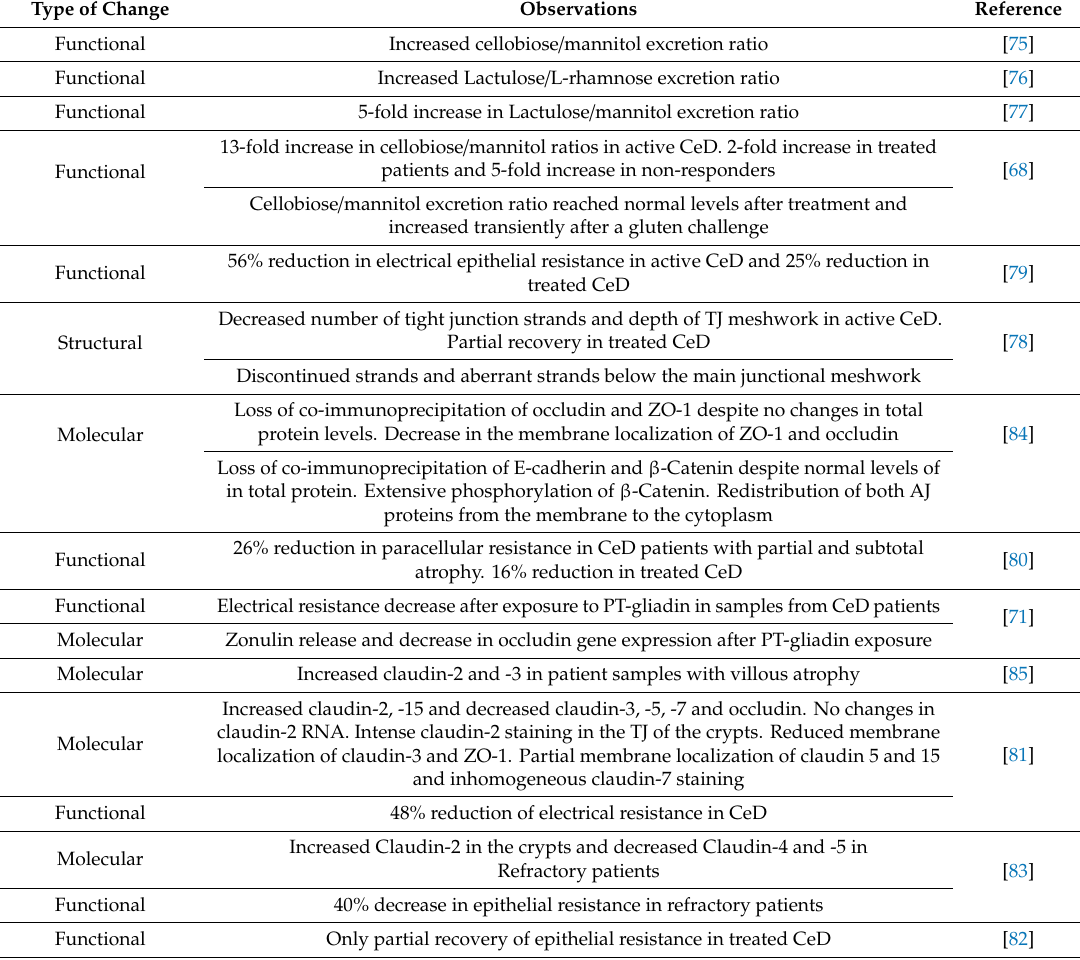
Table 2. Barrier impairment findings in celiac